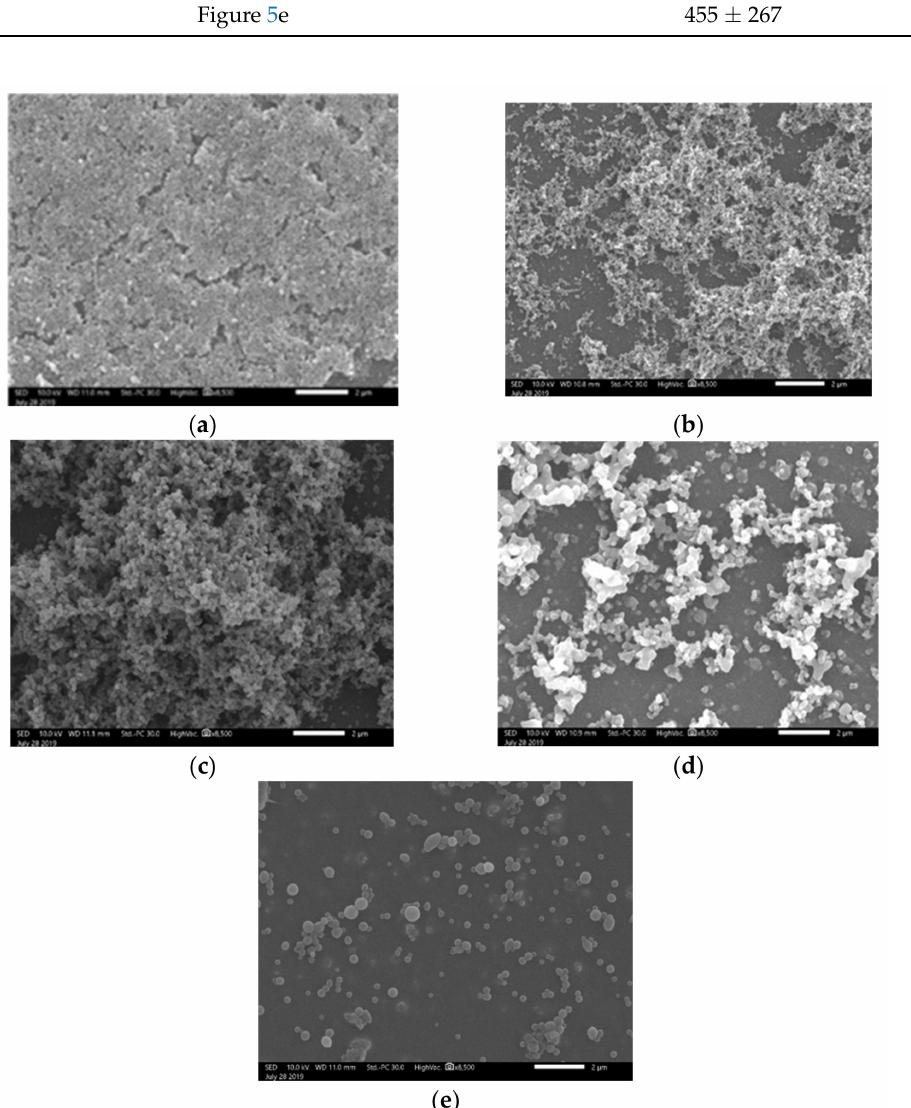
Figure 5. SEM images of coatings based on TEOS:DTMS ratios: ( a ) 7:3, ( b ) 6:4, ( c ) 5:5, ( d ) 4:6, and ( e